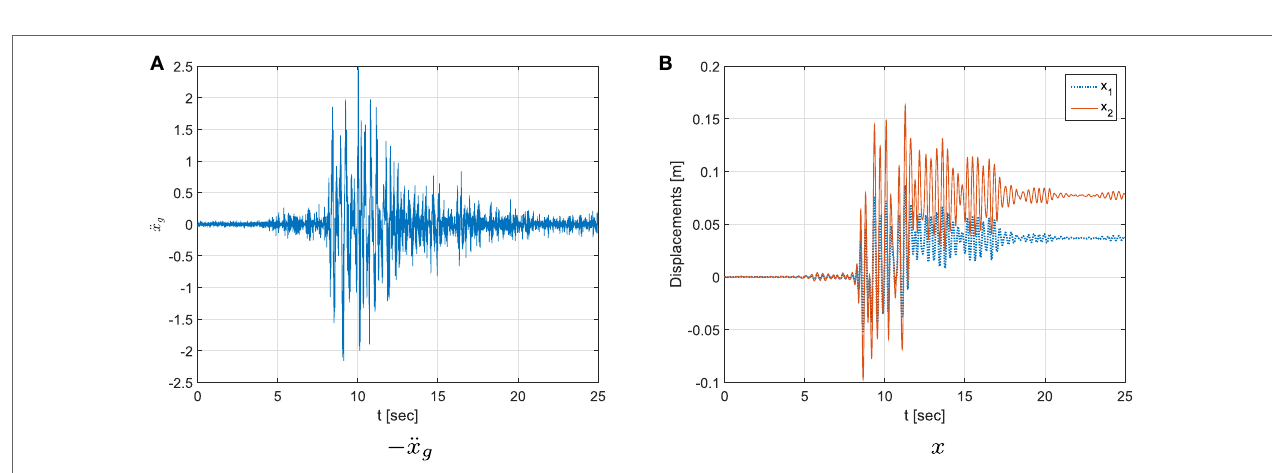
FIGURE 11 | (A) Ground acceleration and (B) displacements of the masses.